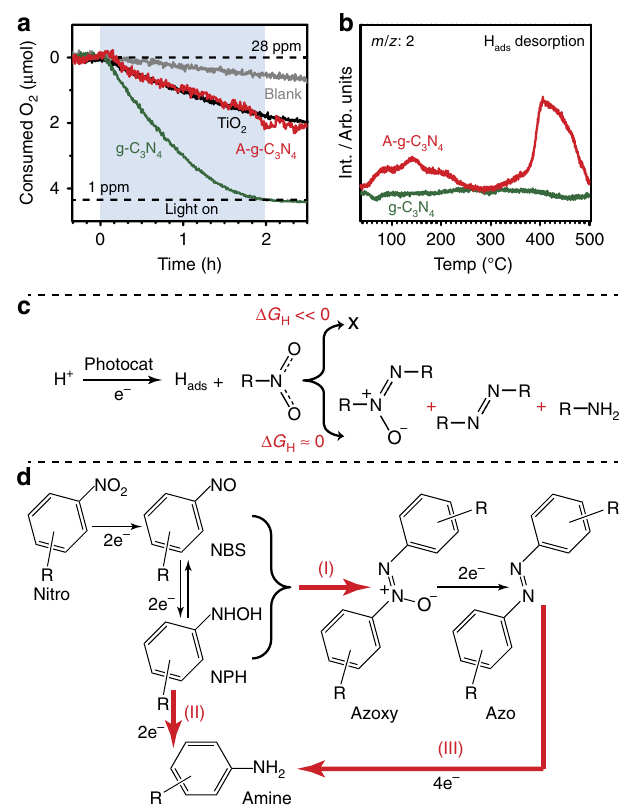
Fig. 2 Reaction mechanism analysis. a The consumption of dissolved O 2 (O 2 reduction and isopropanol oxidation) under irradiation using various photocatalysts determined by in-situ MS. A 365 nm LED was used for TiO 2 and a 450 nm LED was used for all other tests. b Post-mortem TPD spectra revealing the desorption of H ads from the g-C 3 N 4 and A-g-C 3 N 4 surfaces. The TPD was performed on vacuum dried samples after reaction without adsorption of additional H 2 . c Scheme of the suggested reaction pathway.